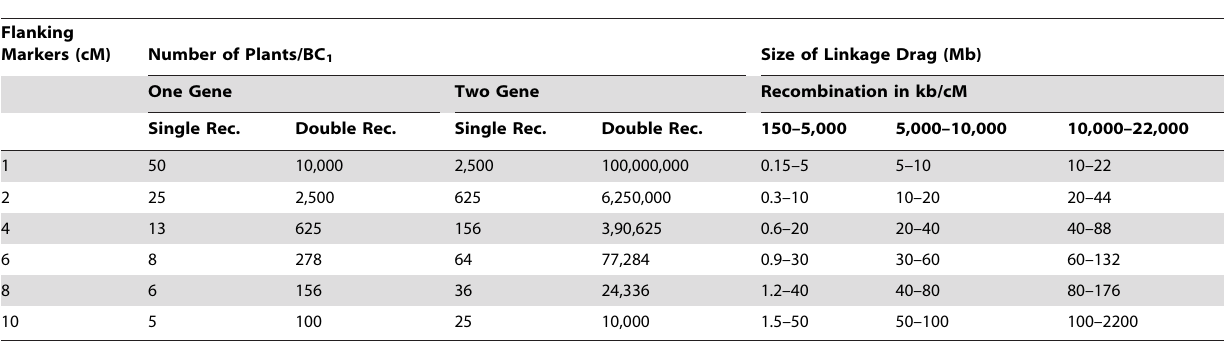
Table 3. Number of plants required to recover single and/or double recombinant (Rec.) with desired physical size. Flanking Markers